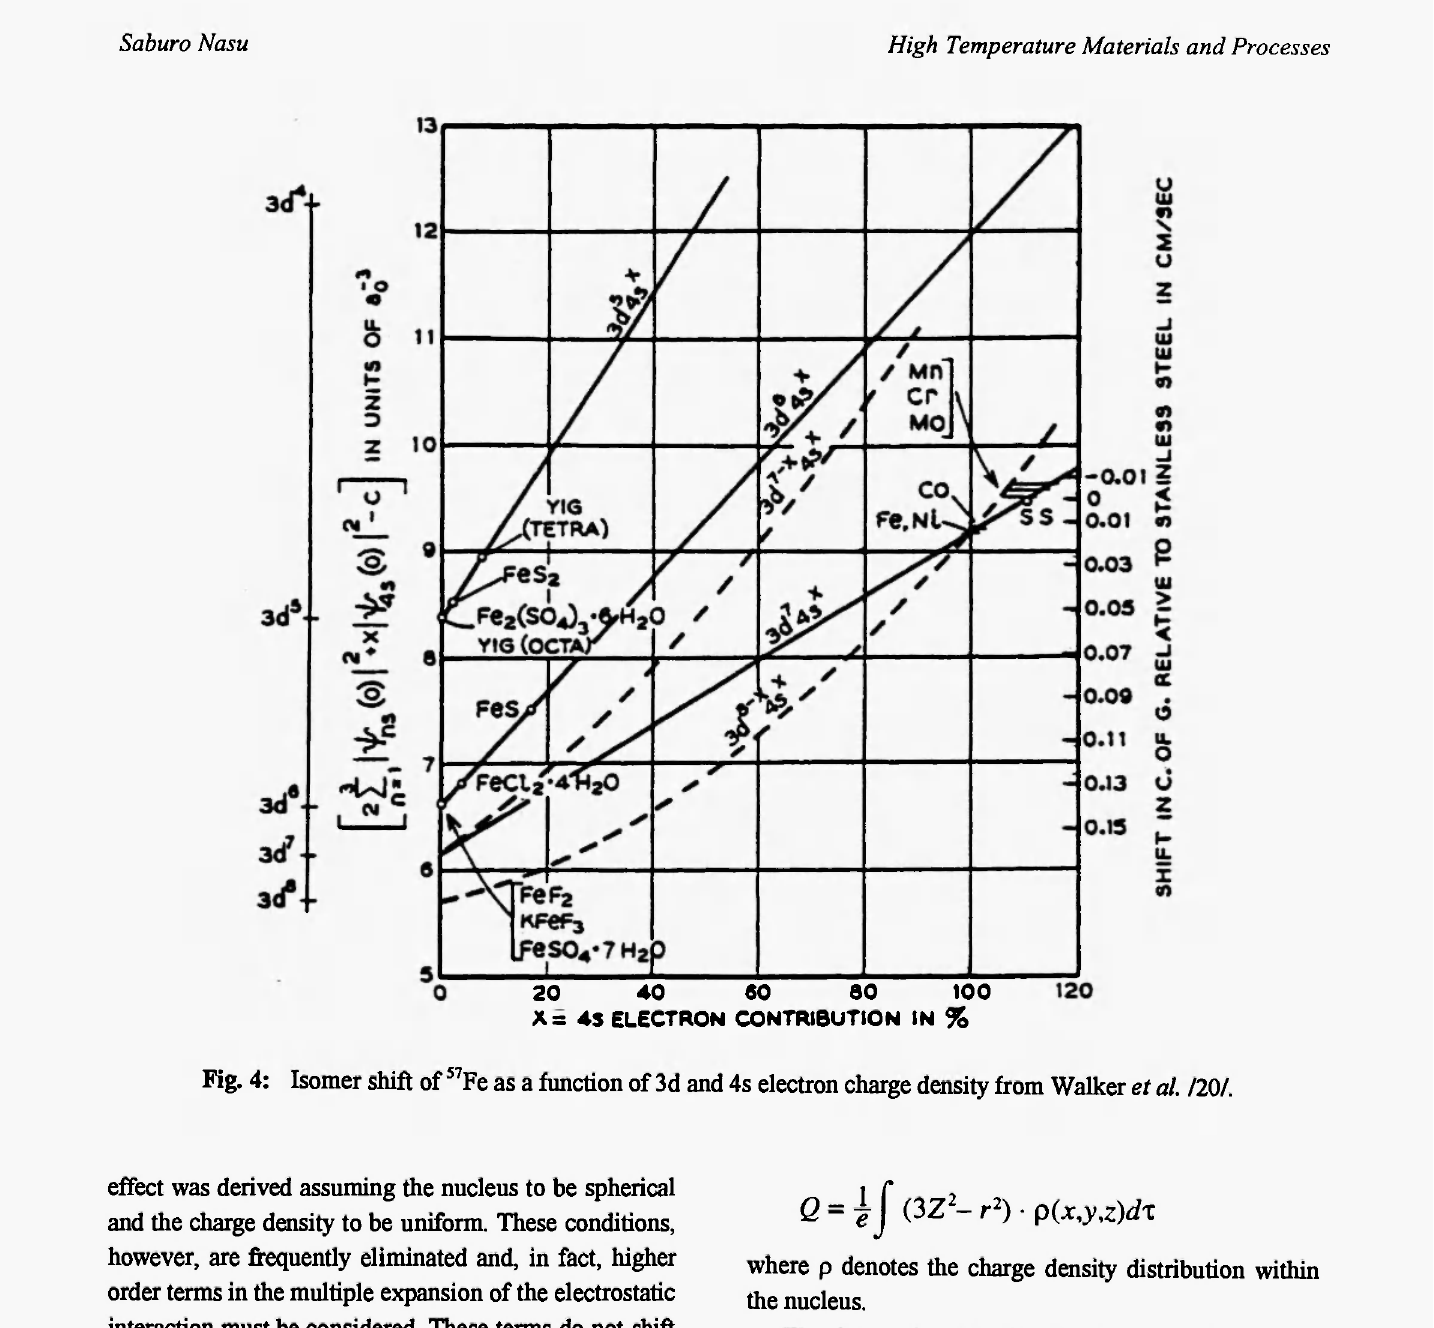
Fig. 4: Isomer shift of 57 Fe as a function of 3d and 4s electron charge density from Walker et cd.